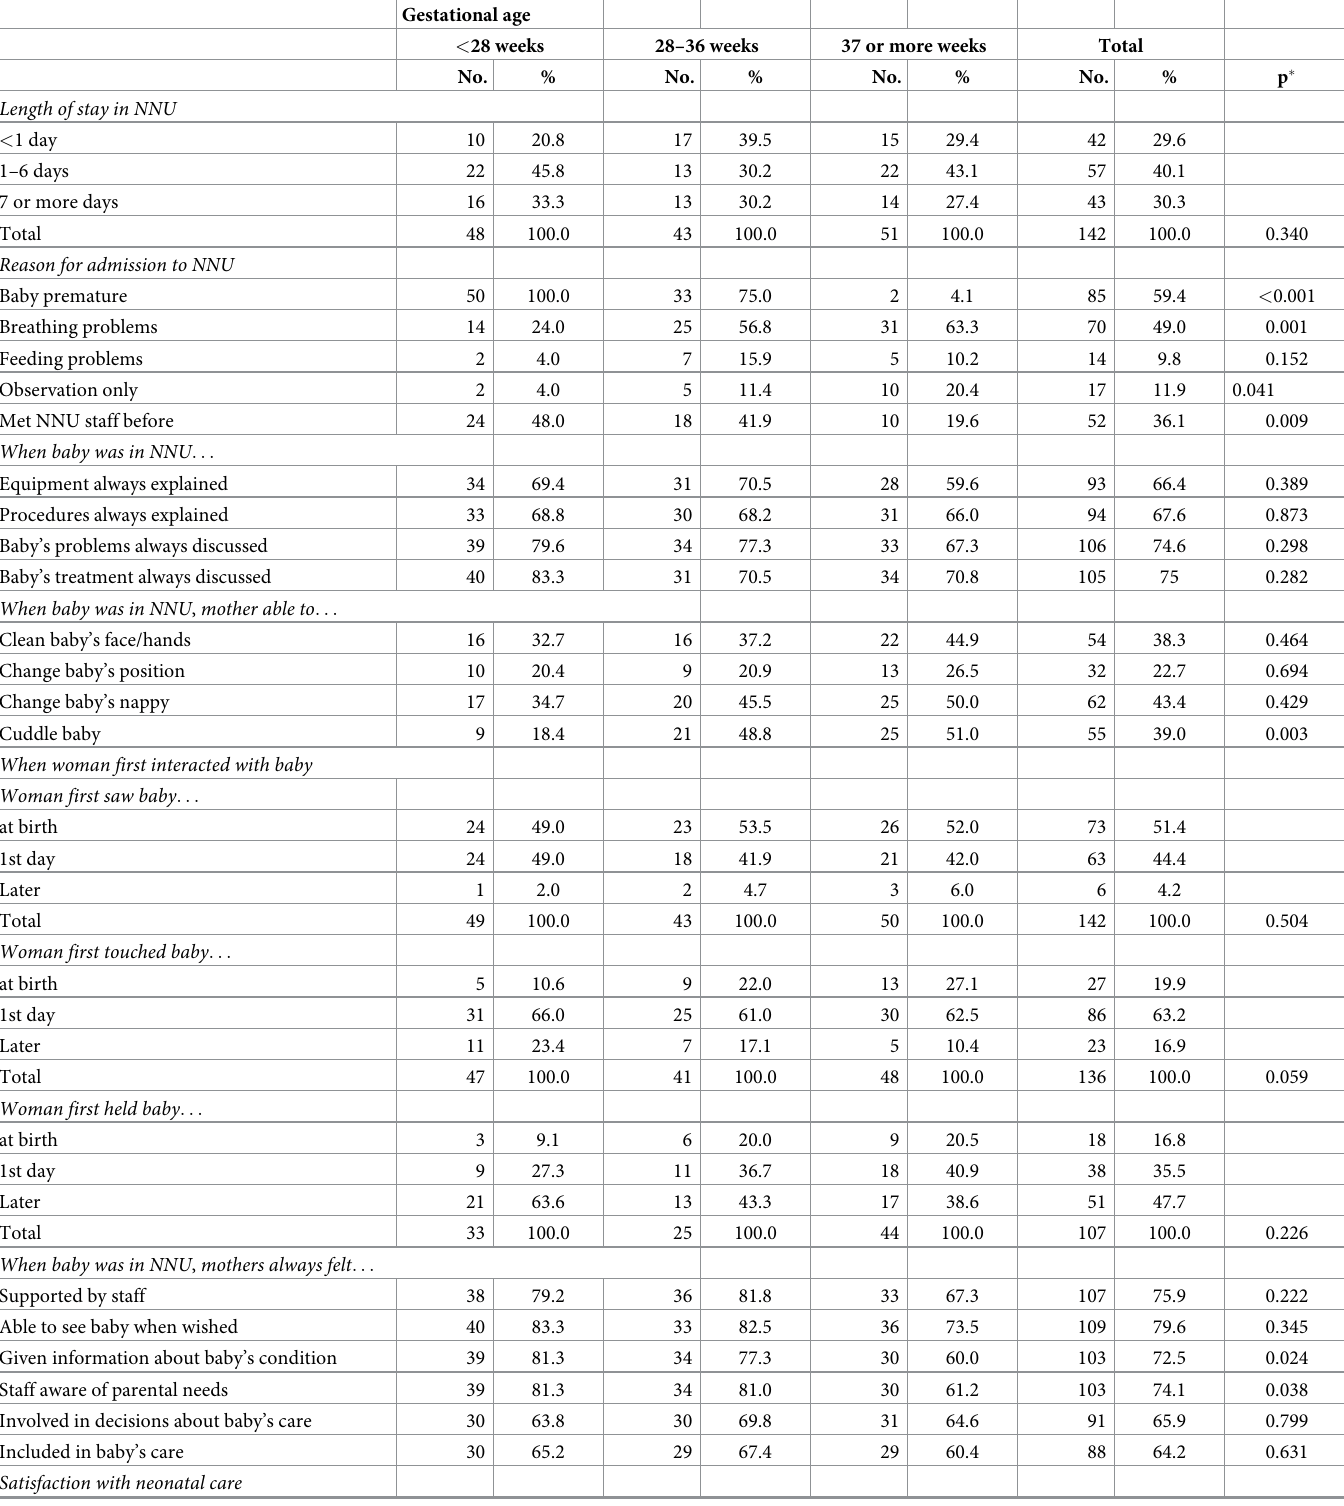
Table 4. Reasons for admission, duration of stay and mother’s perceptions of care in neonatal unit (NNU) by gestational age group. Gestational age < 28 weeks 28–36 weeks 37 or more weeks Total